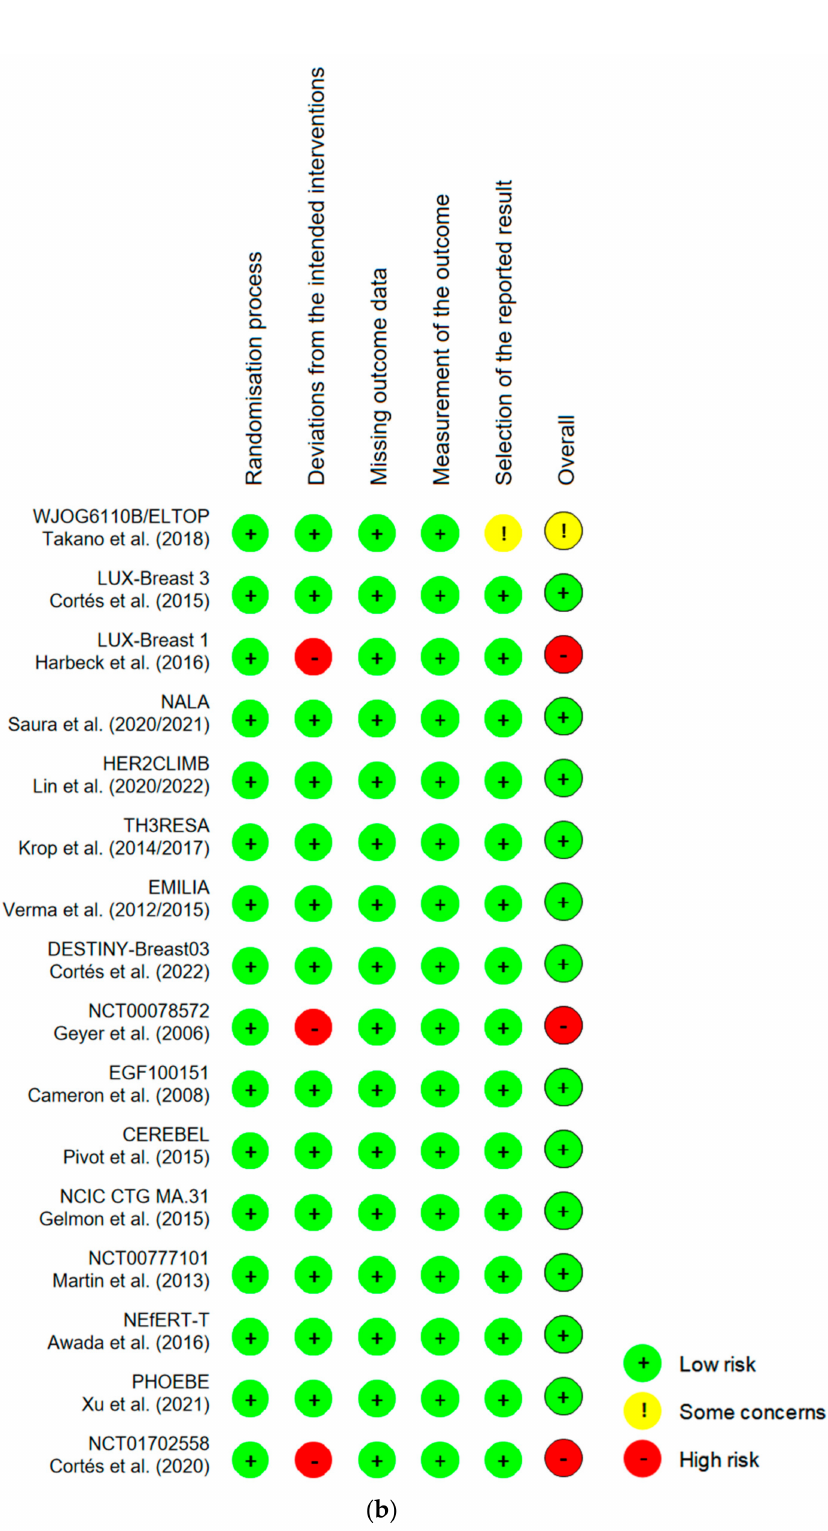
Figure 2. Quality assessment for the bias items of RCTs. ( a ) Risk of the bias summary. ( b ) Risk of the bias